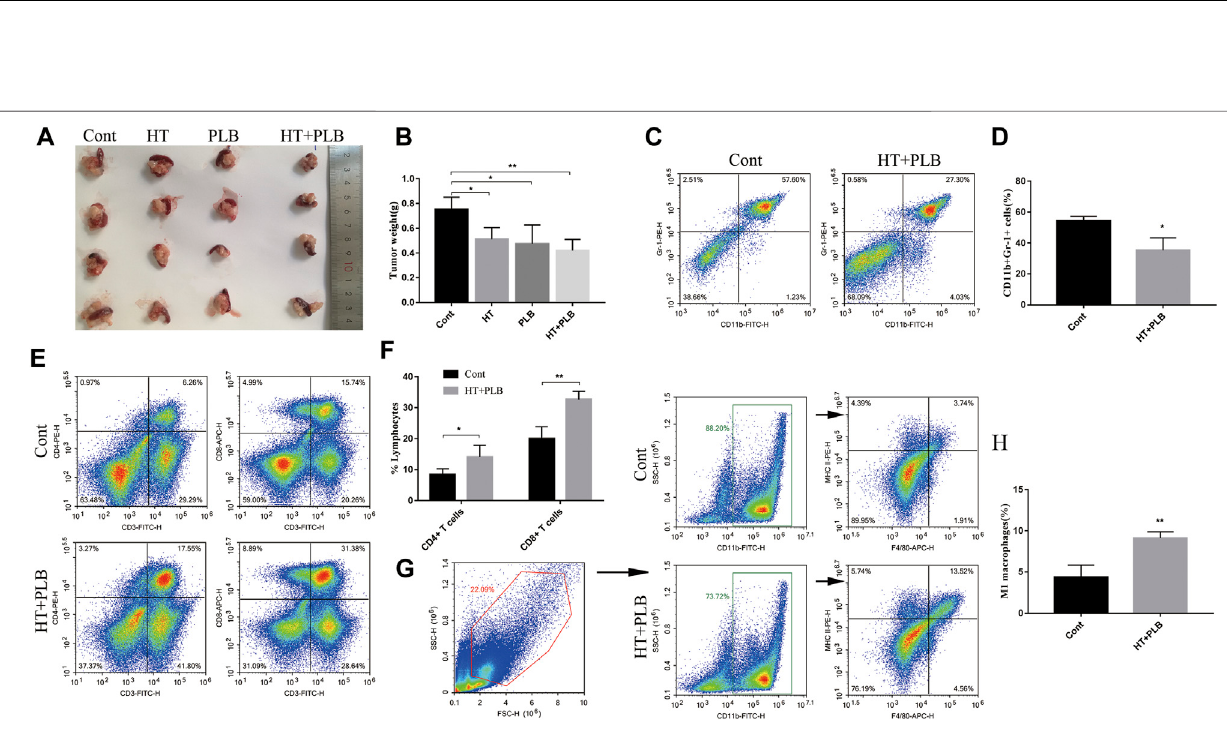
Frontiers in Pharmacology |